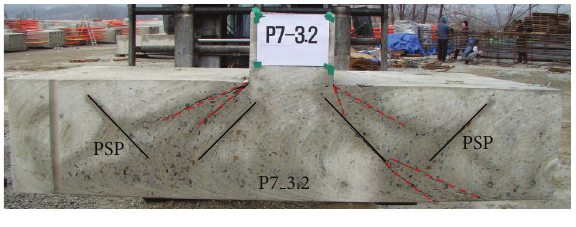
Figure 9: Crack pattern in the middle plane of P7 3.2 test